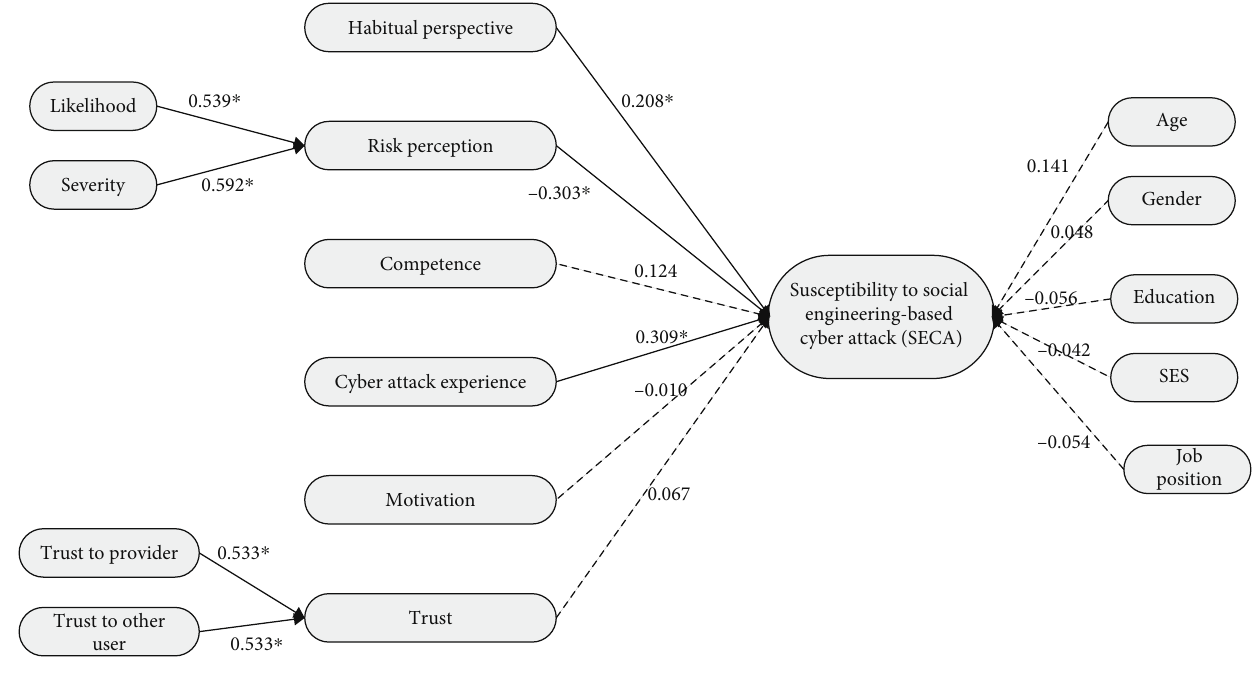
Figure 1: Inner model: loading